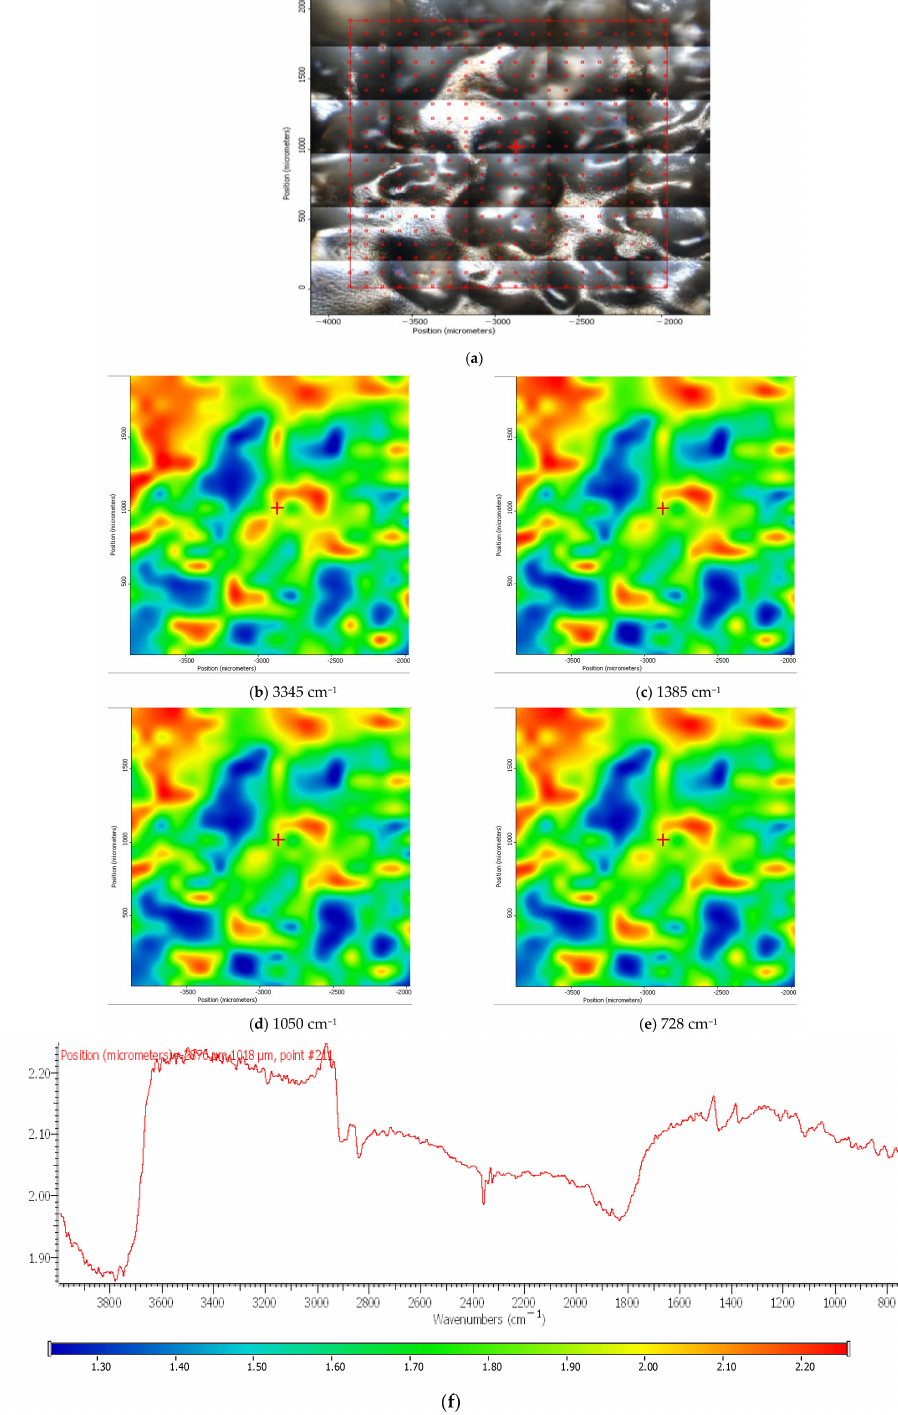
Figure 8. Video-images ( a ), the 2HD-IR obtained maps at the specific wave number ( b – e ); and infrared associated spectrum and color scales ( f ); for Chi/sEPDM composite